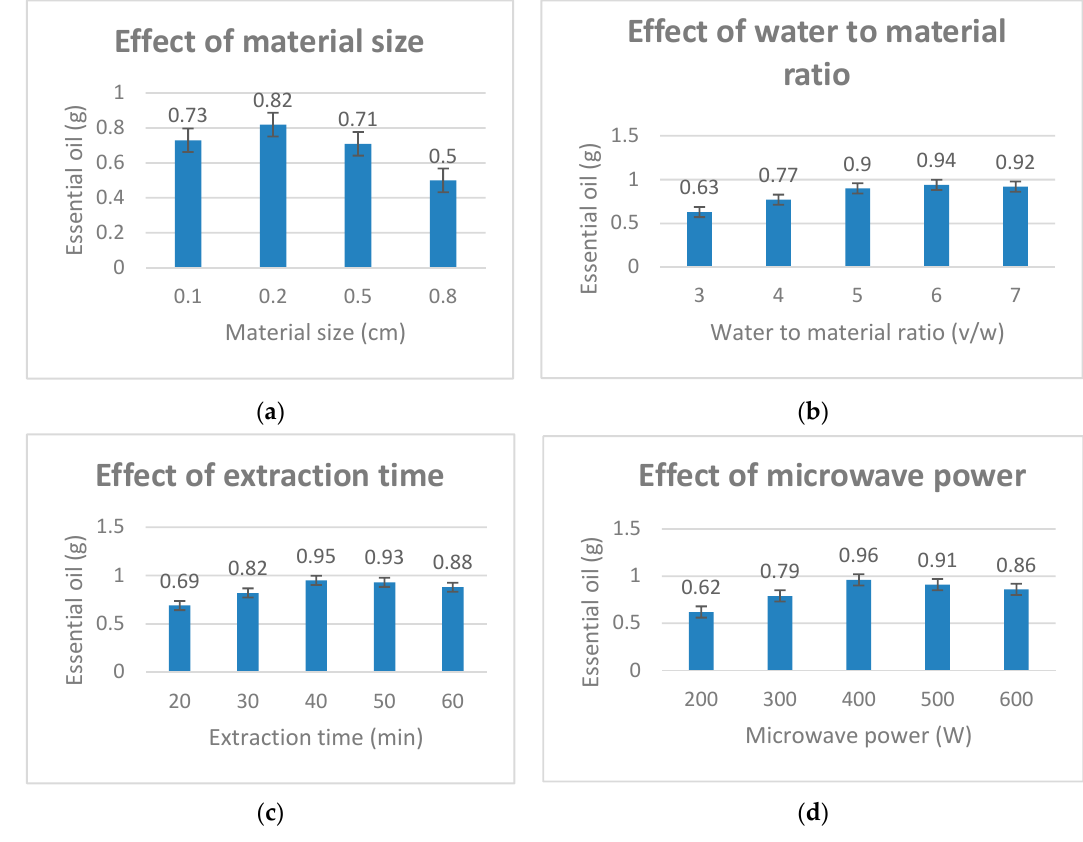
Figure 1. Single factor investigations showing effect of ( a ) size of the materials; ( b ) water-to-material ratio; ( c ) time of extraction; and ( d ) microwave power on the efficiency of essential oil extraction.